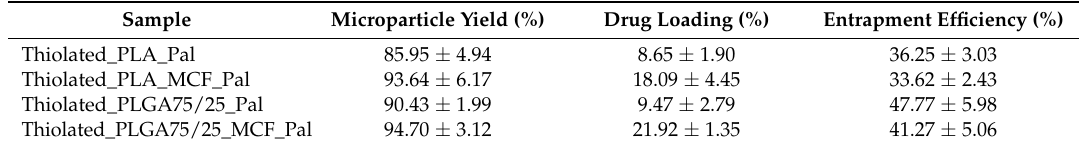
Table 1. Microparticles yield (%), drug loading (%), and entrapment efficiency (%) of prepared thiolated coated